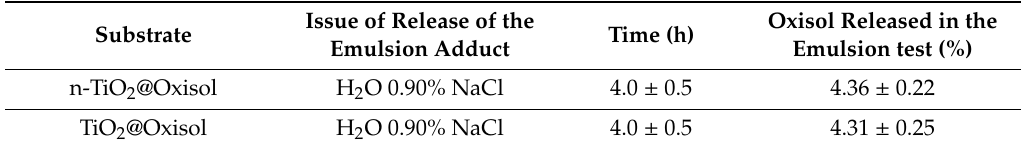
Table 7. Oxisol percentage released from emulsions. The percentage are referred to Oxisol linked to TiO 2